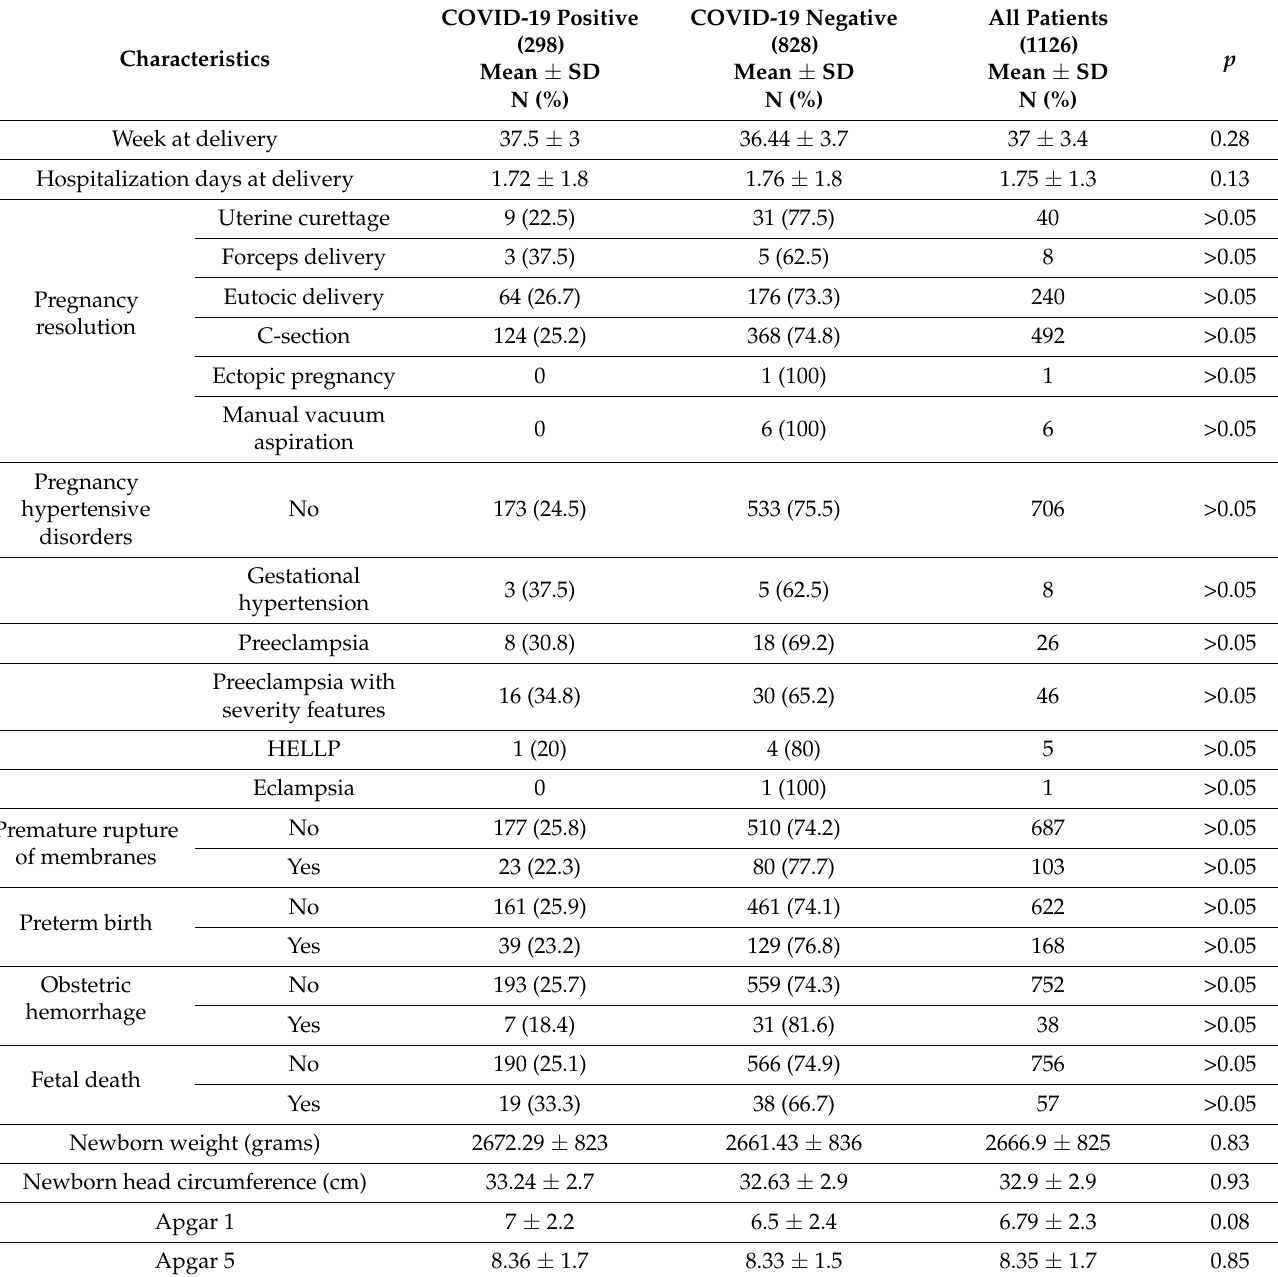
Table 3. Pregnancy